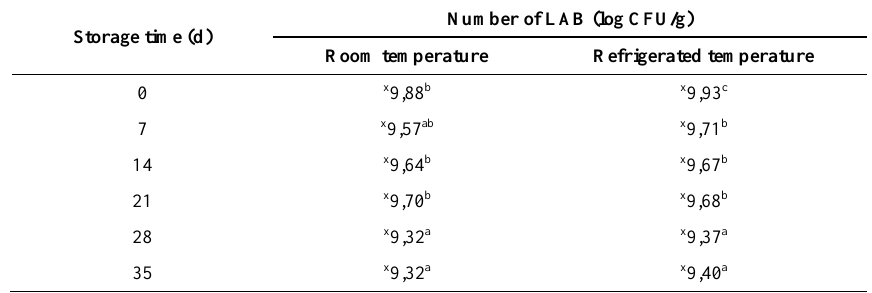
Table 7. Number of strain B1295 microencapsulated with CMFH from OPT at different temperatures for 35 days storage and treated with bile Number of LAB (log CFU/g) Storage time (d) Room temperature Refrigerated temperature